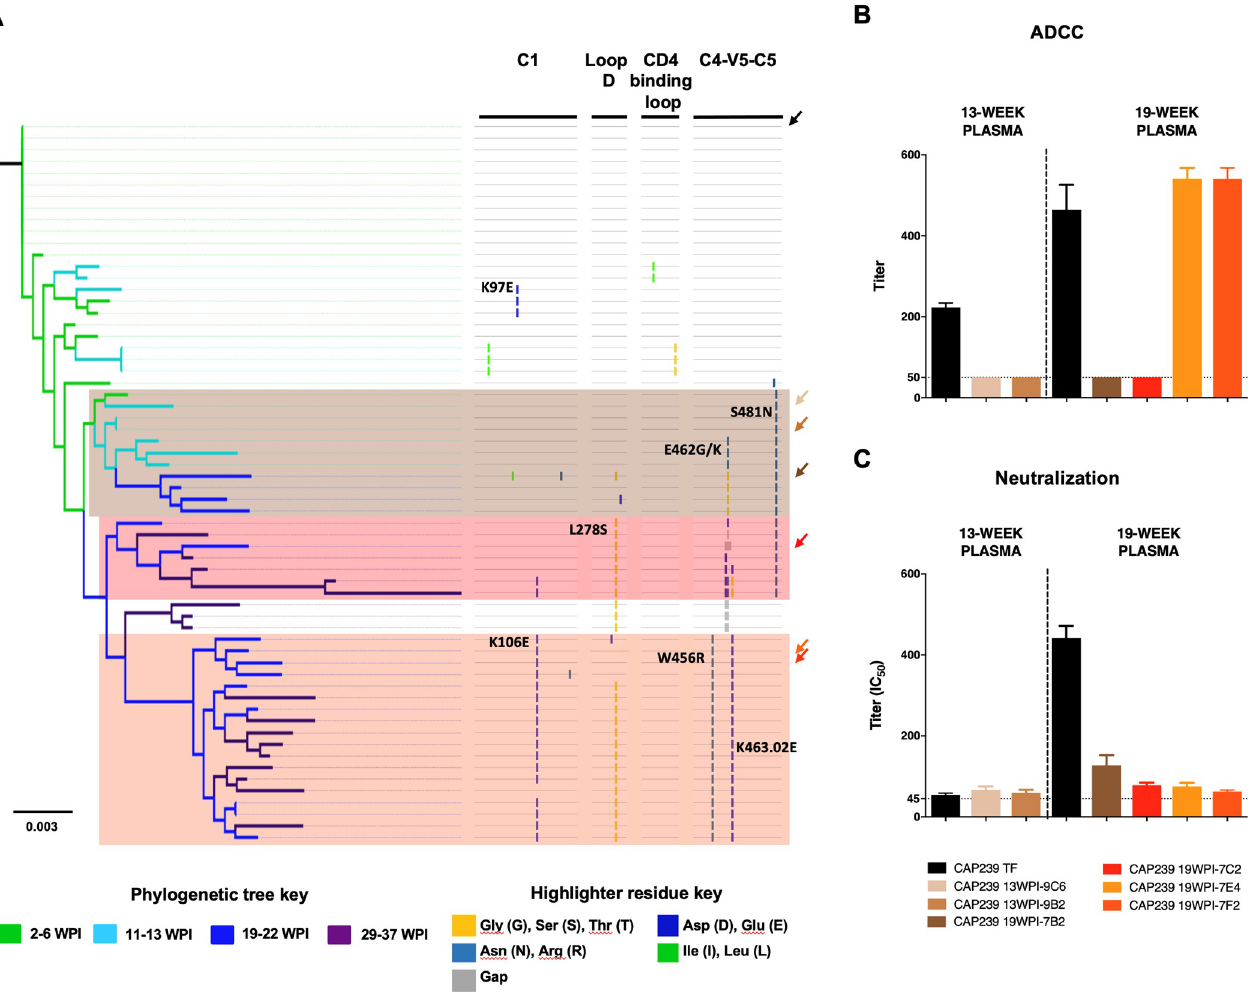
Fig 2. Impact of ADCC and neutralization responses on evolutionary pathways in CD4-binding site regions of CAP239 viruses. (A) A maximum- likelihood tree of the 61 CAP239 full-length env single genome sequences was constructed, and rooted on the T/F virus. Branches were colour-coded according to the time-point from which the sequence was sampled. Three distinct evolutionary pathways were observed following detection of nAbs. Arrows indicated sequence used to generate infectious molecular clones containing the env of the T/F (black) as well as six representative sequences from the three pathways were constructed (identified by arrows coloured according to pathway). Two of the clones (CAP239 13WPI-9C6 and CAP239 13WPI-9B2) were representative of 13 week viruses; while four viruses (CAP239 19WPI-7B2, CAP239 19WPI-7C2, CAP239 19WPI-7F2 and CAP239 19WPI-7E4) represented 19 week viruses. (B) Env-IMCs were tested against contemporaneous plasma was tested for ADCC activity. (C) Env-IMCs were tested against contemporaneous plasma for neutralization activity. Points on ADCC and neutralisation plots indicate the mean of � three independent